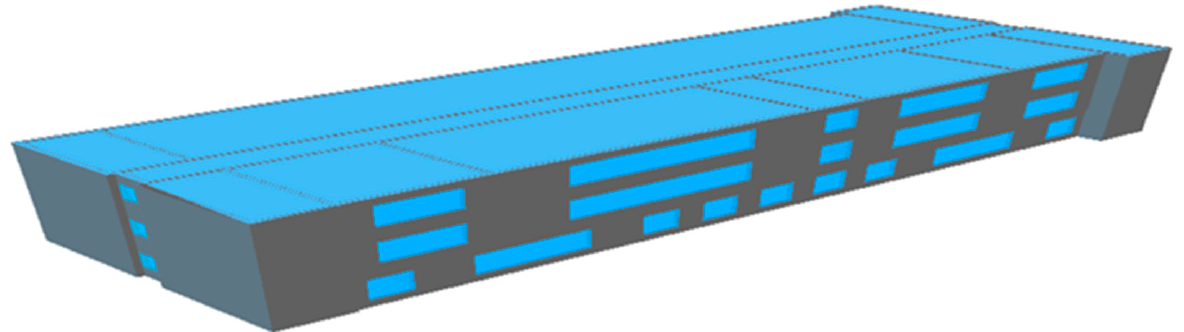
Figure 1. DeST building model of staff dormitory.